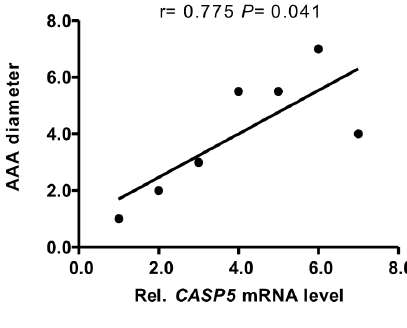
Figure 2. Correlation of CASP5 mRNA ex- pression in PBMC of female AAA-patients. Spearman ′ s rank test was used for analysis.